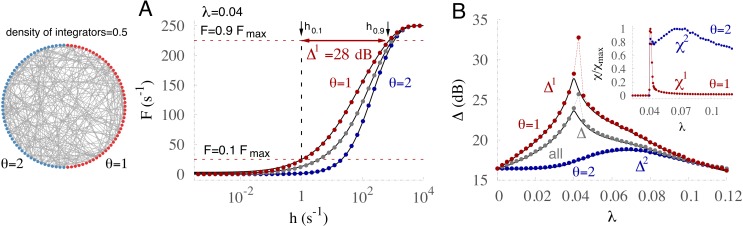
A specialized subpopulation with increased coding performance emerges with diversity.(A) Response curves (mean firing rate F versus stimulus rate h) for the subpopulations of θ = 2 (blue), θ = 1 (red), and the whole network (gray). Variables F0.1 and F0.9 (red dashed lines), and h0.1 and h0.9 (black arrows) are used to calculate the dynamic range Δ1 (red arrow) for the subpopulation with θ = 1, where \documentclass[12pt]{minimal}
\usepackage{amsmath}
\usepackage{wasysym}
\usepackage{amsfonts}
\usepackage{amssymb}
\usepackage{amsbsy}
\usepackage{upgreek}
\usepackage{mathrsfs}
\setlength{\oddsidemargin}{-69pt}
\begin{document}
}{}${F}_{x}={F}_{0}+x{F}_{\mathrm{max}}$\end{document}Fx=F0+xFmax, hx is the corresponding input rate to the system, and F0 is the firing rate in the absence of input. Solid black lines correspond to the mean-field approximation (see ‘Methods’). (B) Dynamic range Δ is optimized for different coupling strengths λ for the two subpopulations. Dotted lines connect the numerical data points. Inset: susceptibility χθ for the two corresponding subpopulations; susceptibility maxima coincide with the peaks of the dynamic range. Susceptibility was calculated over 500 trials of 100 ms after transients of 0.5 s.